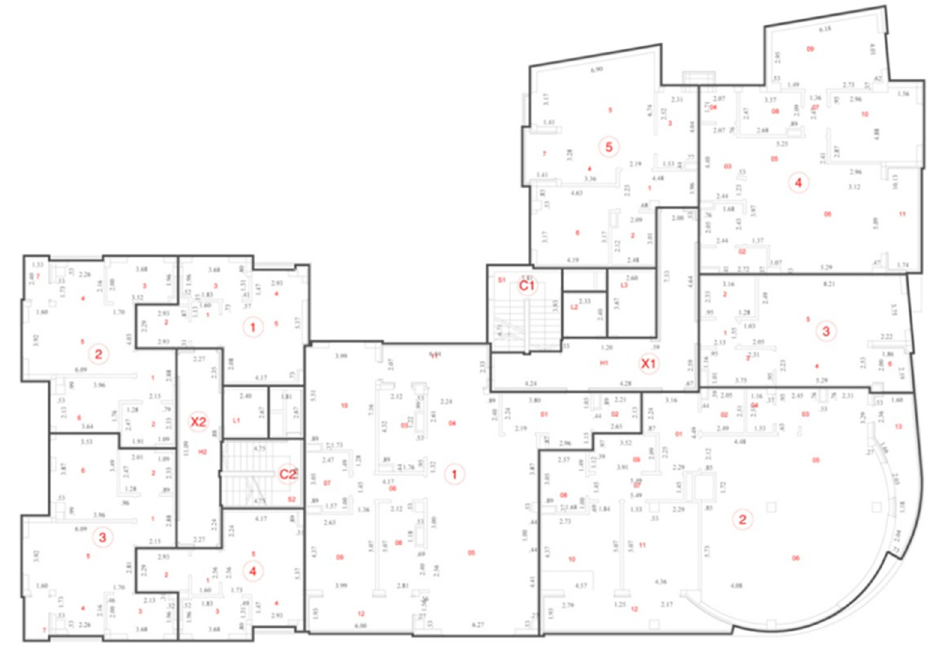
Figure 5. Example of the floor plan used for creating 3D cadastral data.